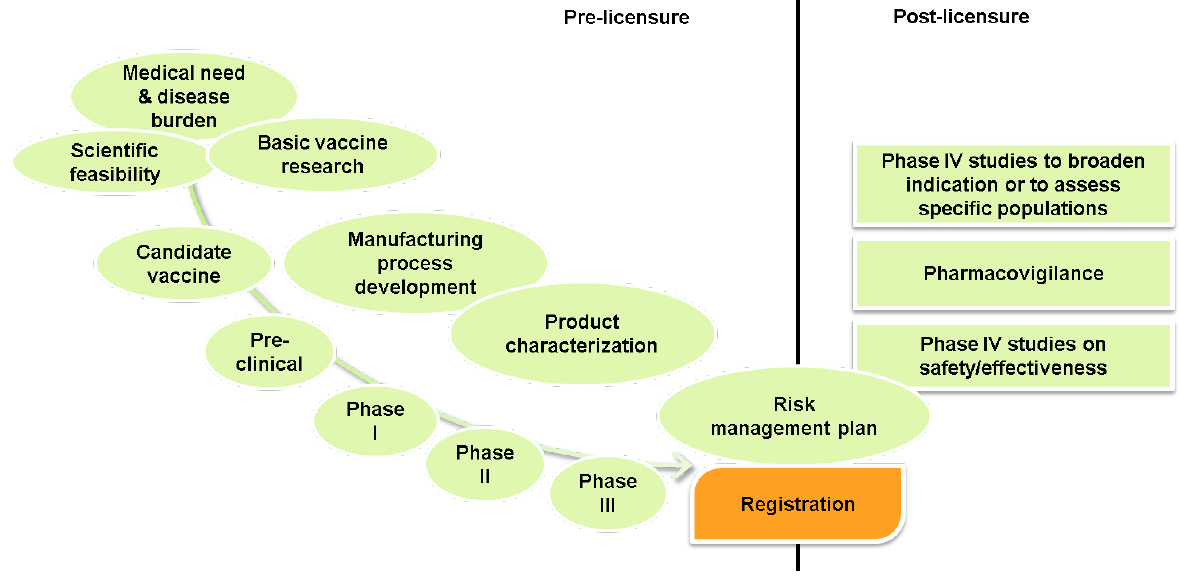
Figure 2. Pre- and post-licensure vaccine development